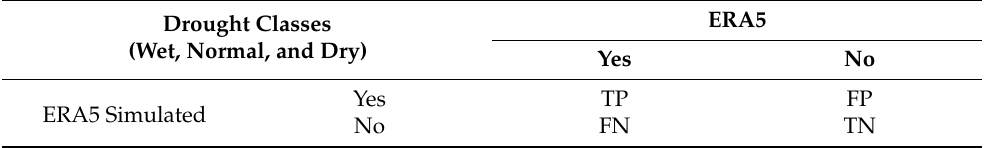
Table 3. Contingency table for analysis of drought event detection by ERA5 data.